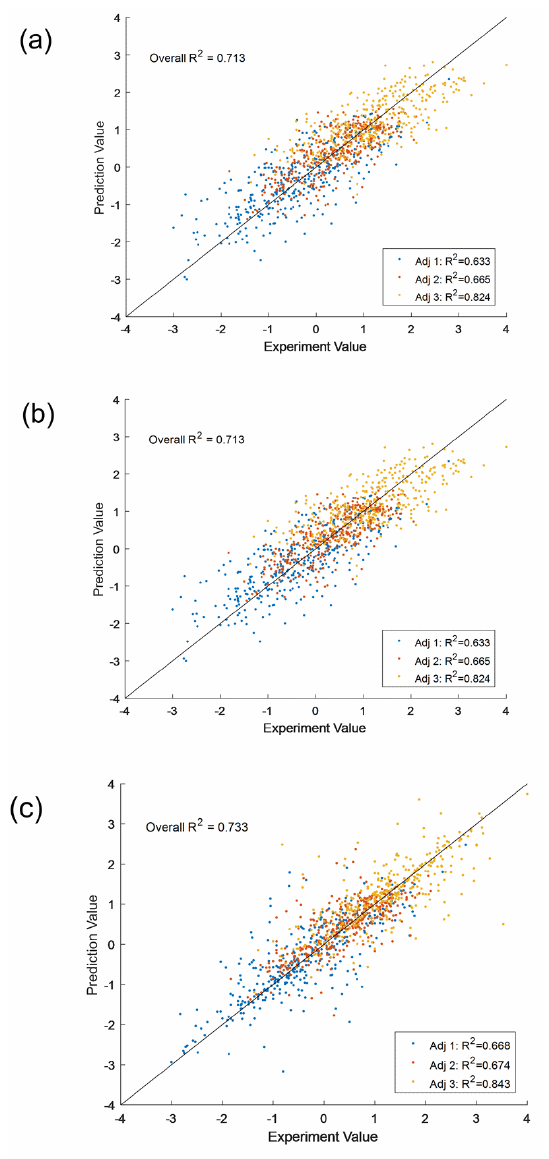
Figure 5. Prediction results of models with different numbers of hidden layers. ( a ) one hidden layer (16); ( b ) two hidden layers (35 × 5); ( c ) three hidden layers (28 × 38 × 19).